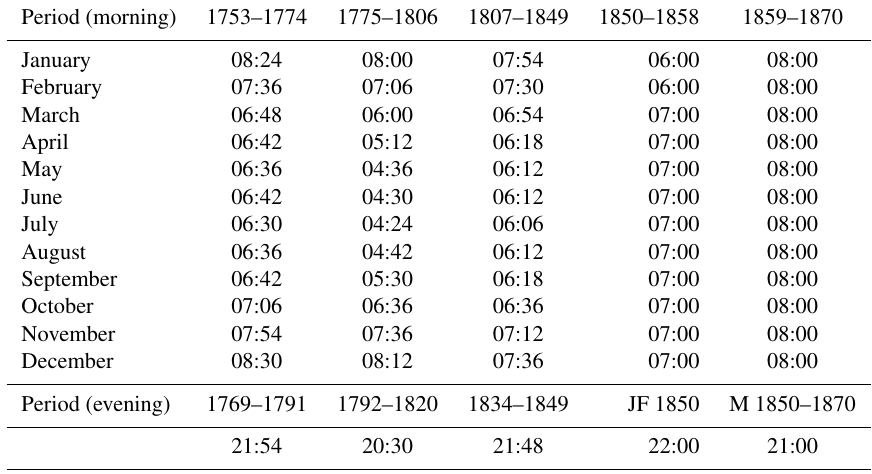
Table A2. Average time of day for morning and evening measurements, 1753–1870. Period (morning)